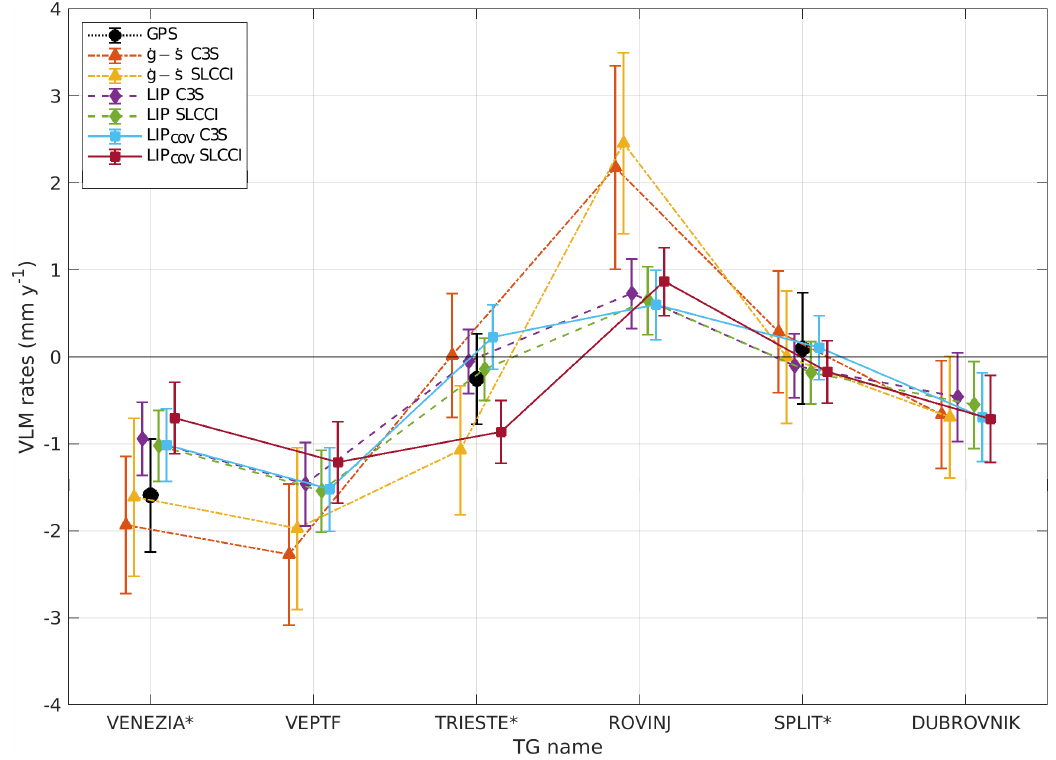
. . g − s ), LIP method, and LIP cov